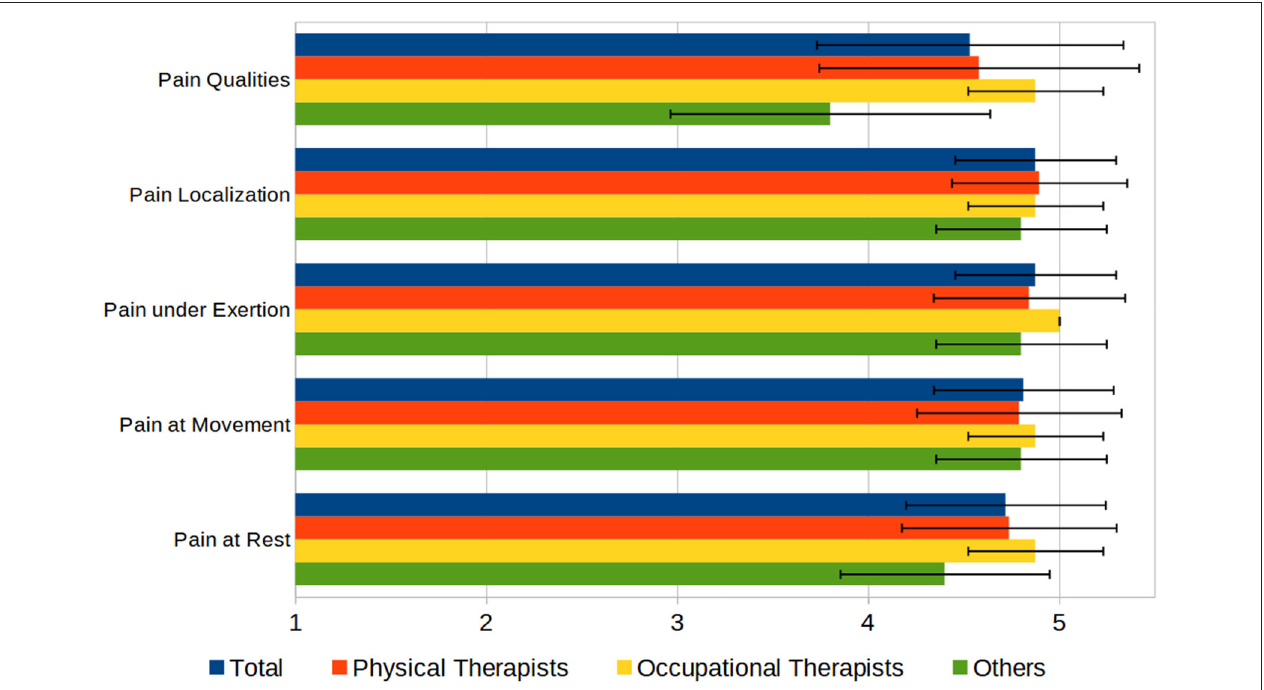
FIGURE 7 | Principal functions of C.A.L.A., rated by usefulness on a 1–5 scale (1 = “not useful,” 5 = “very useful”).